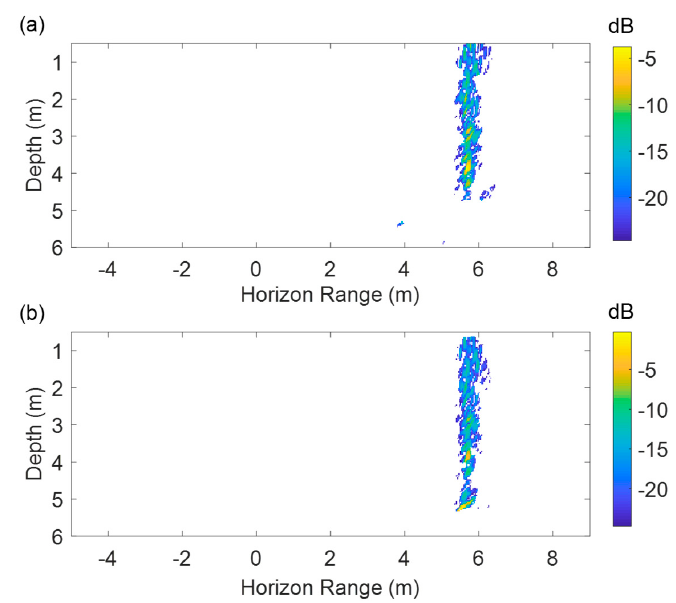
Figure 12. Results obtained by screening the data in Figure 8 using thresholds of image amplitude and velocity intensity. ( a ) and ( b ) correspond to the processing results of Scheme A and Scheme B,